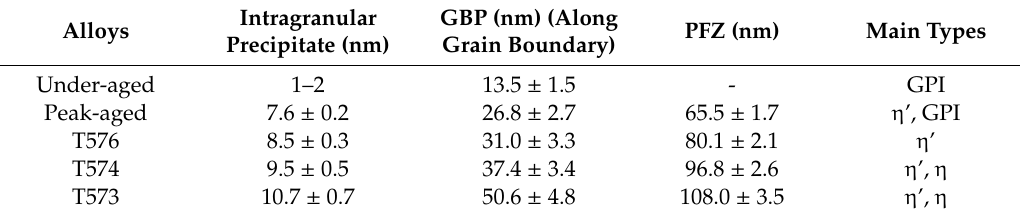
Figure 6. TEM bright-field images and corresponding SAED patterns for ( a , b ) T576 alloy, ( c , d ) T574 alloy and ( e , f ) T573 alloy. Table 3. Precipitation characteristics analyses of di ff erent aged